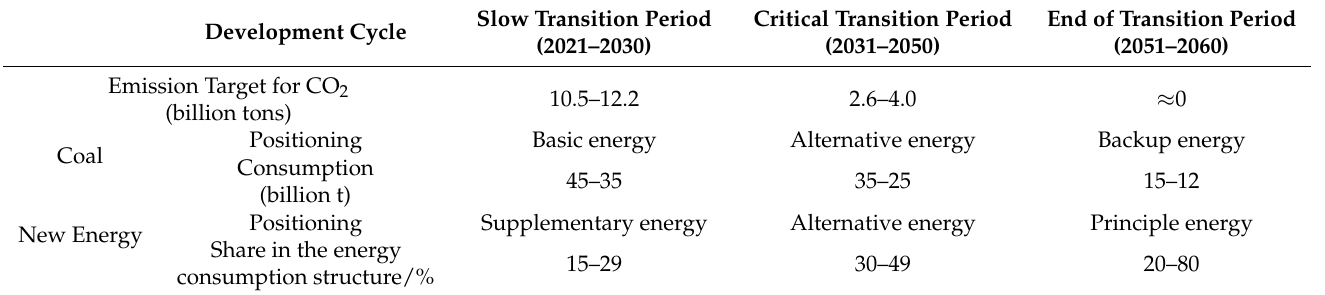
Table 1. Expected CO 2 emissions in each phase and the position of coal and new energy in the energy mix.